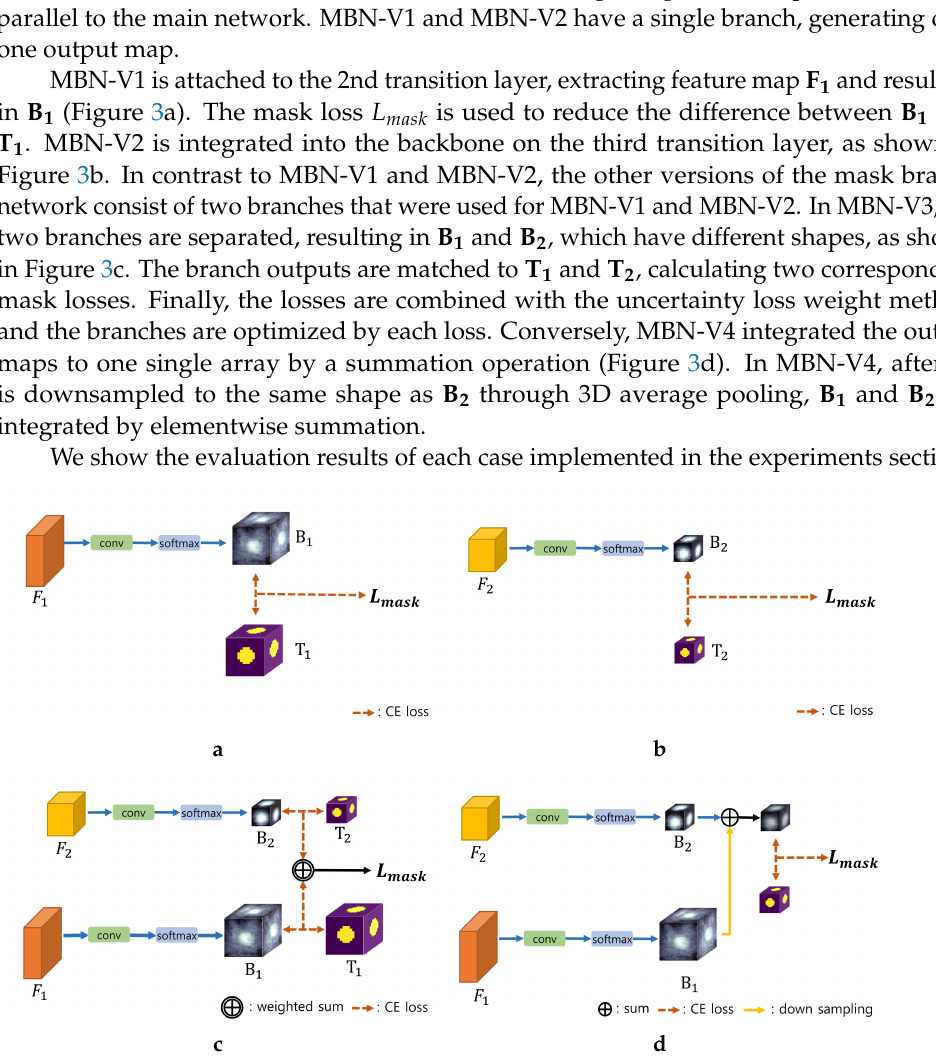
Figure 3. Architectures of the mask branch network we proposed with DenseNet. ( a , b ) MBN-V1, MBN-V2 with a single subnet, where each branch is attached to conv2 and conv3. ( c , d ) MBN-V3, MBN-V4 with multiple branch subnets containing branches of both MBN-V1 and MBN-V2. In MBN-V3 of ( c ), the losses are calculated with each branch output separately. MBN-V4 combines the branch outputs by summation and calculates loss in once, as shown as ( d